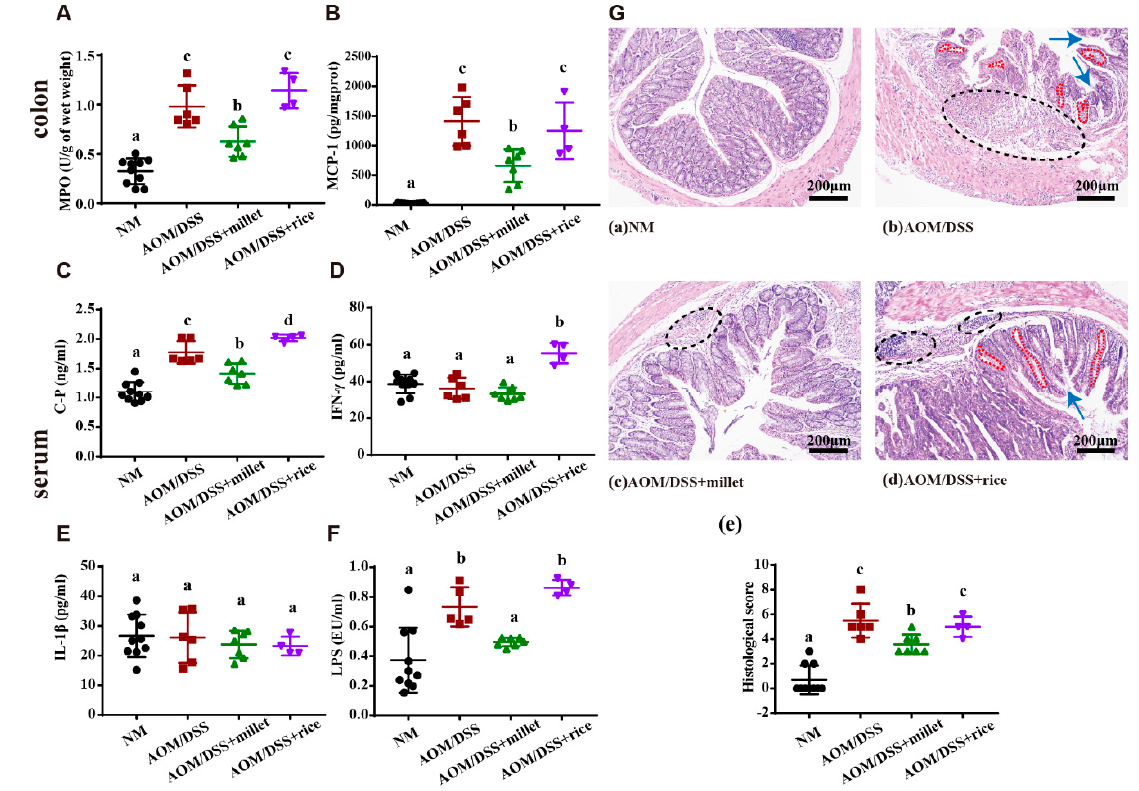
Figure 3. Macroscopic and histological assessments of colitis. Colonic ( A ) myeloperoxidase (MPO) and ( B ) monocyte chemotactic protein 1 (MCP-1); serum ( C ) C-P, ( D ) IFN- γ , ( E ) IL-1 β , and ( F ) LPS. ( G ) Representative H&E staining of the formalin fixed sections of the colonic tissues. The black ellipses indicate inflammatory infiltration; the blue arrows indicate crypt defect; and the red curves indicate crypt distortion. Magnification: × 100 (upper). Data are shown as the mean ± SD. Means with di ff erent letters are significantly di ff erent ( p < 0.05). n = 10, 6, 7, and 4 for NM, AOM / DSS, AOM / DSS + millet, and AOM / DSS + rice groups, respectively.